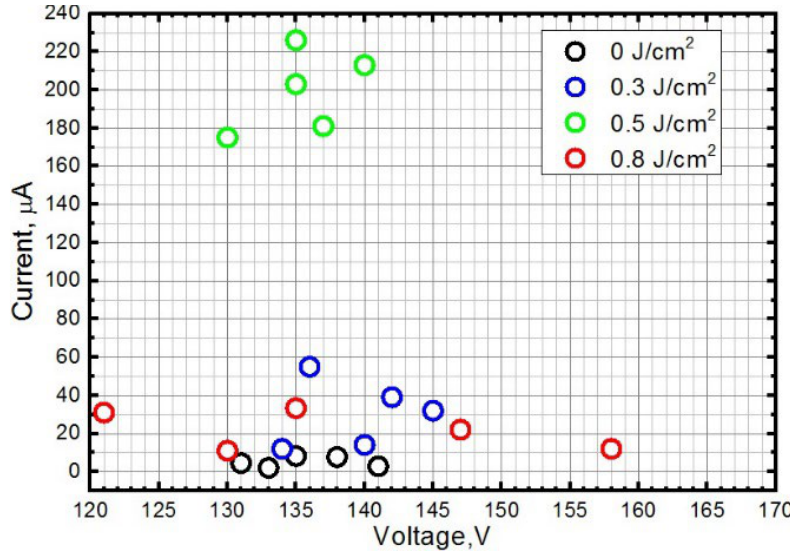
Figure 12. The maximum current–voltage values of the layer based on rGO(bl)-SWCNT for the region before (0 J/cm 2 ) and after laser exposure with an energy density of 0.3, 0.5, and 0.8 J/cm 2 .